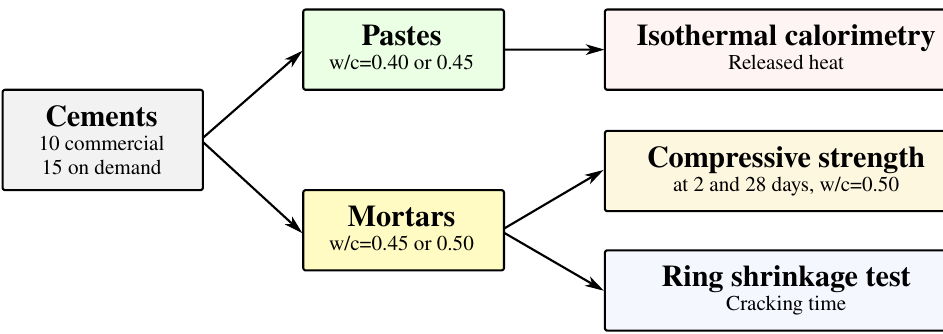
Figure 4. Workflow of experiments for testing 25 cements. Isothermal calorimetry was conducted in the TamAIR (Thermometric AB, Stochholm, Sweden) calorimeter at 20 ◦ C. The pastes were mixed externally by hand for approximately 30 s and vibrated in the IKA Vortex I orbital shaker for 20 s. The procedure followed the prEN 196-11 Method “A” external mixing with two modifications. Fourteen pastes were tested according to prEN 196-11 at w / c = 0.40, while eleven pastes had a higher w / c = 0.45 matching mostly the ring’s mortars. The second modification used heat flow integration from 45 min after mixing. The heat released before 45 min was calculated from the known initial temperature, the estimated heat capacity and the heat up to 45 min. The released heat between 0 and 45 min reached 5–19 J/g of cement. The calorimetry always used two samples with approximately 18 g of cement in each ampoule, and the differences were negligible. The evolution of compressive strength was carried out according to the EN 196-1 standard on three